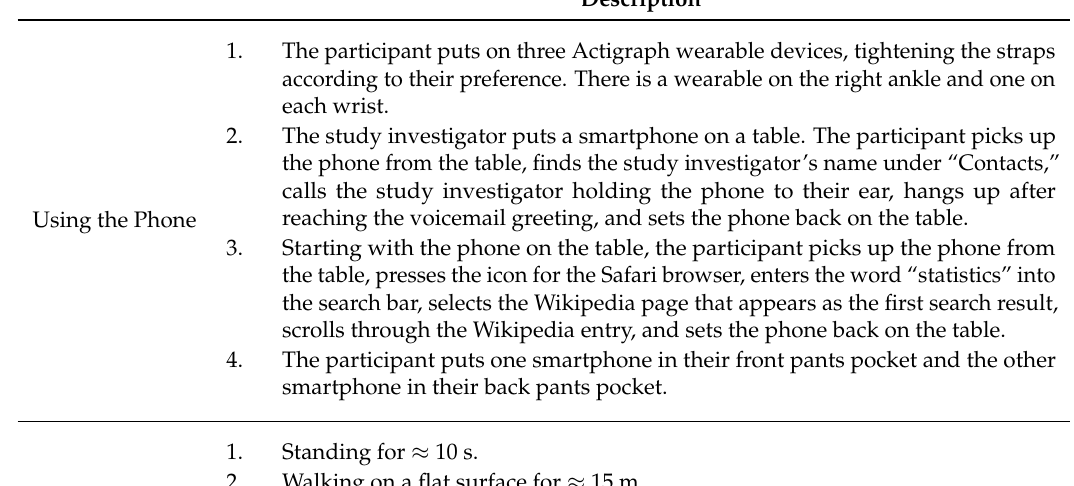
Table 1. Outline of study protocol.